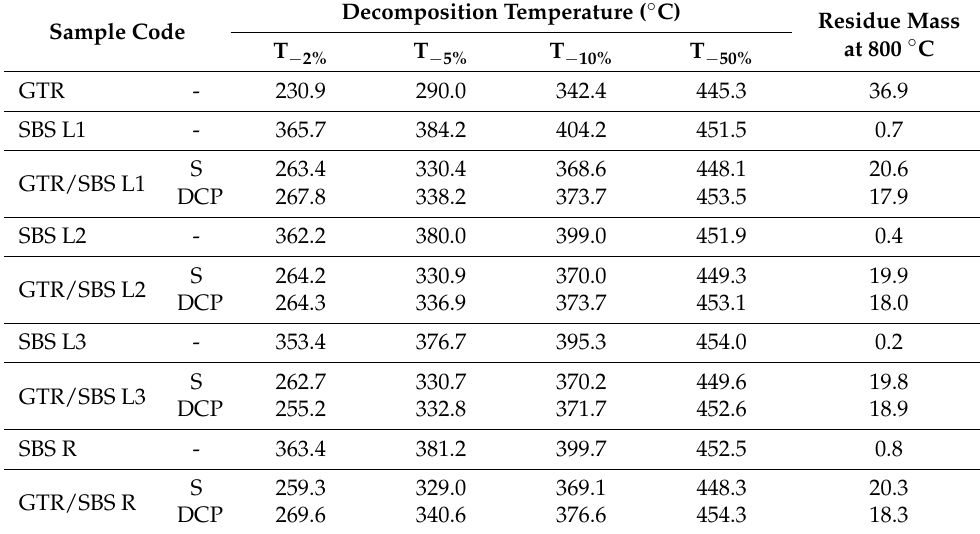
Table 5. Thermal decomposition temperatures and residue mass of GTR/SBS